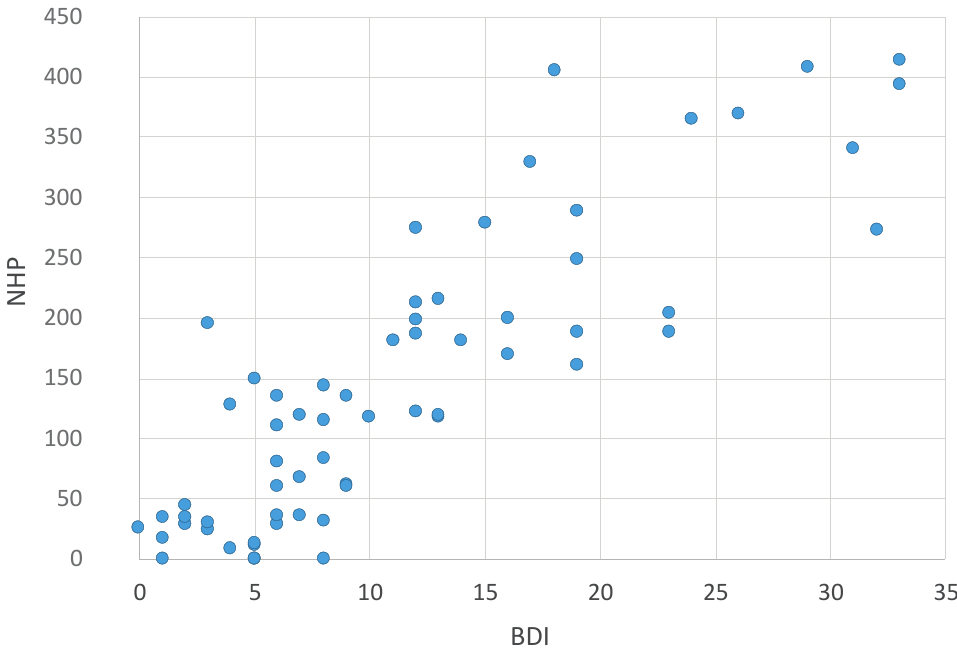
Figure 3. Correlation between NHP and MFIS values. Abbreviations: NHP = Nottingham Health Profile; MFIS = Modified Fatigue Impact Scale [13].